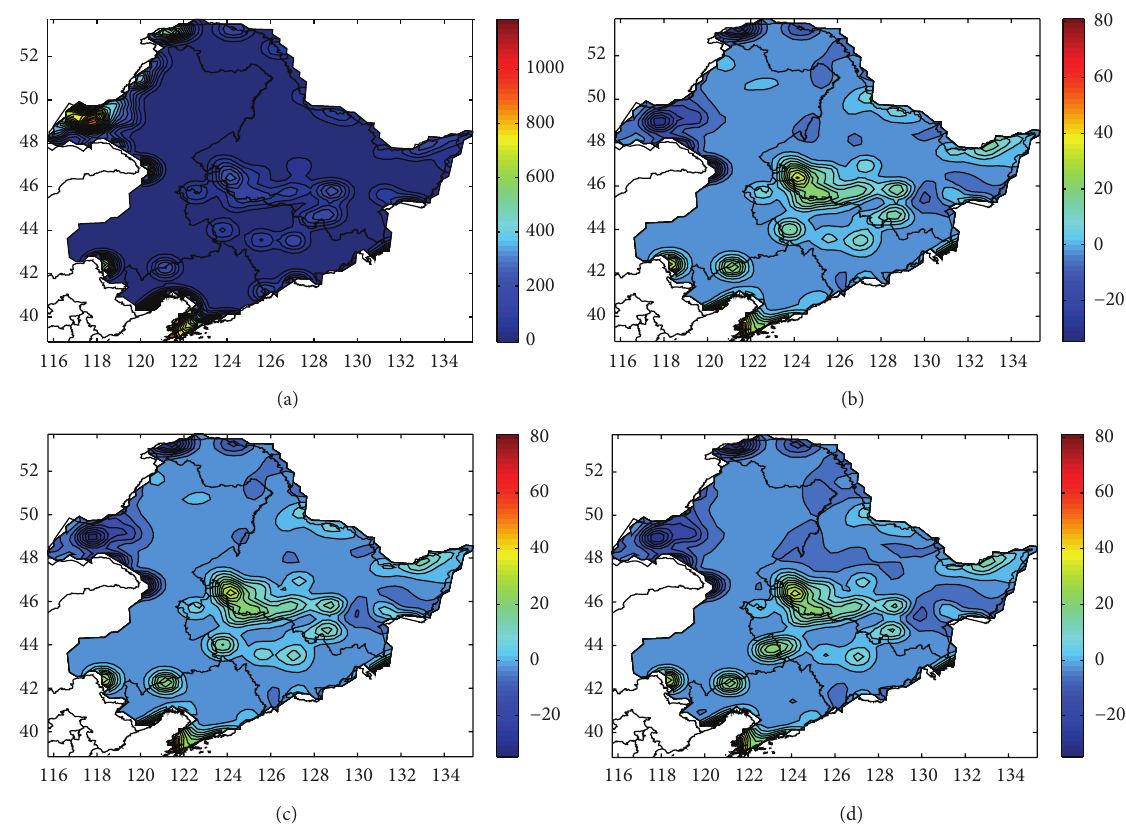
Figure 3: Difference between the latent heat flux in Northeast China in 2010 and 2030 under different scenarios (unit: W/m 2 ). (a) Spatial pattern of the latent heat flux in 2010; (b) difference of the latent heat flux between 2010 and 2030 under the BAU scenario; (c) difference of the latent heat flux between 2010 and 2030 under the REG scenario; (d) difference of the latent heat flux between 2010 and 2030 under the CES